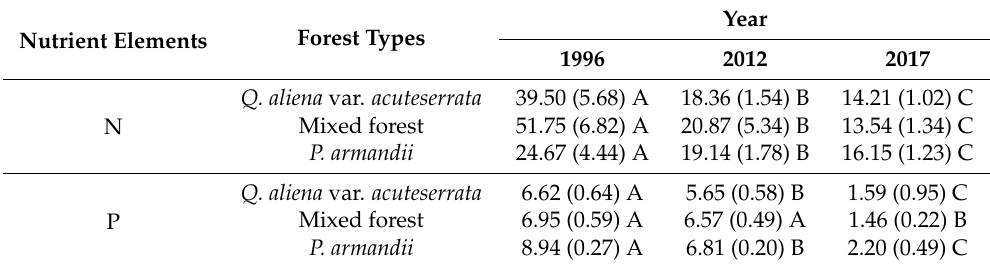
Standard errors are shown in parentheses, and different capital letters within the same row indicate significant differences among means ( p < 0.05).